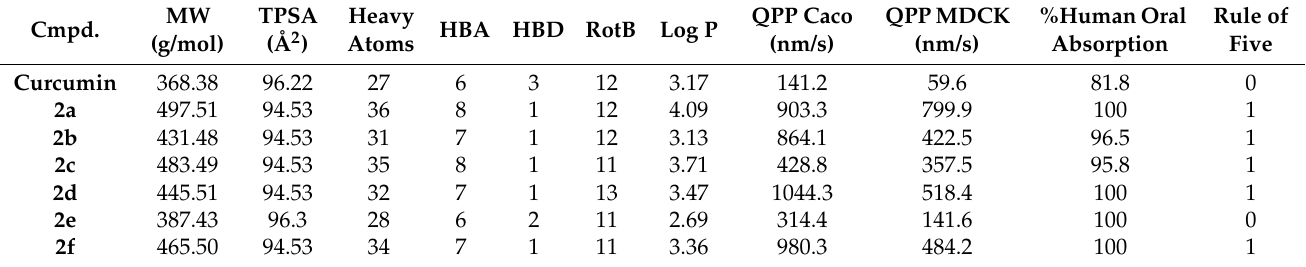
Table 1. Physicochemical and ADME properties predicted for compounds 2a – f